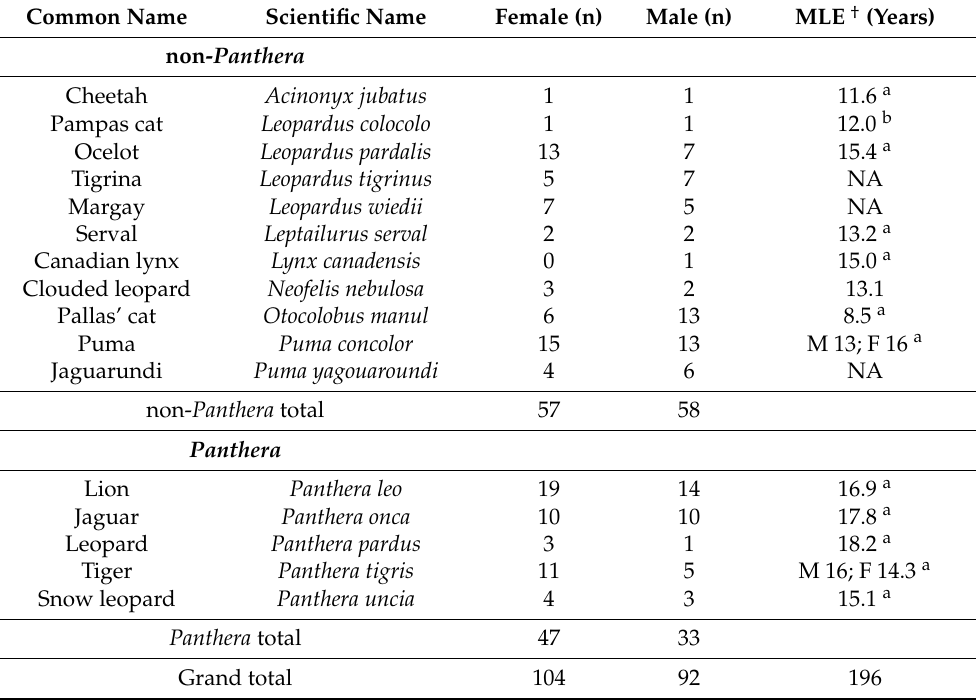
Table 2. List of species included in the survey of neoplasia in felids from zoos in the US, Mexico, Peru, Colombia, and